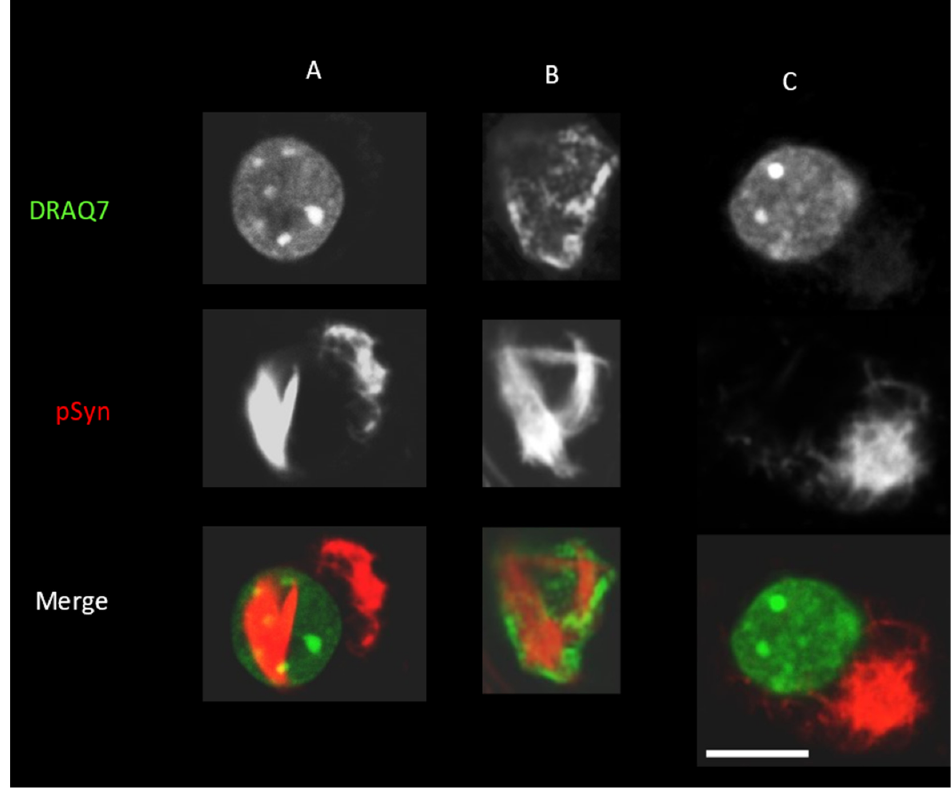
Figure 7. LSCM optical sections of 30 DIV mouse primary cortical neurons treated at DIV7 with 1B fibrils. Merge: DNA (DRAQ7) coded in green, phospho-S129 α -Syn (pSyn) coded in red. For description of ( A , B , C ) see text. Scale bar: 10 μ m.